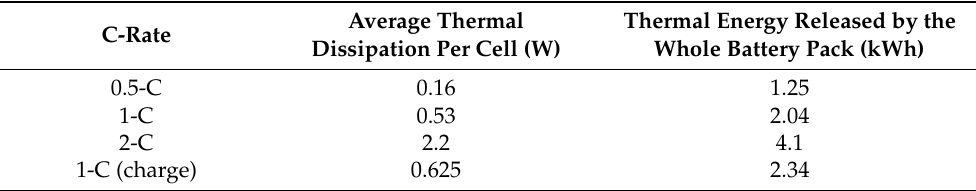
Table 1. Thermal energy released by a cell and corresponding energy dissipation of the whole battery pack at different discharge C-rates.